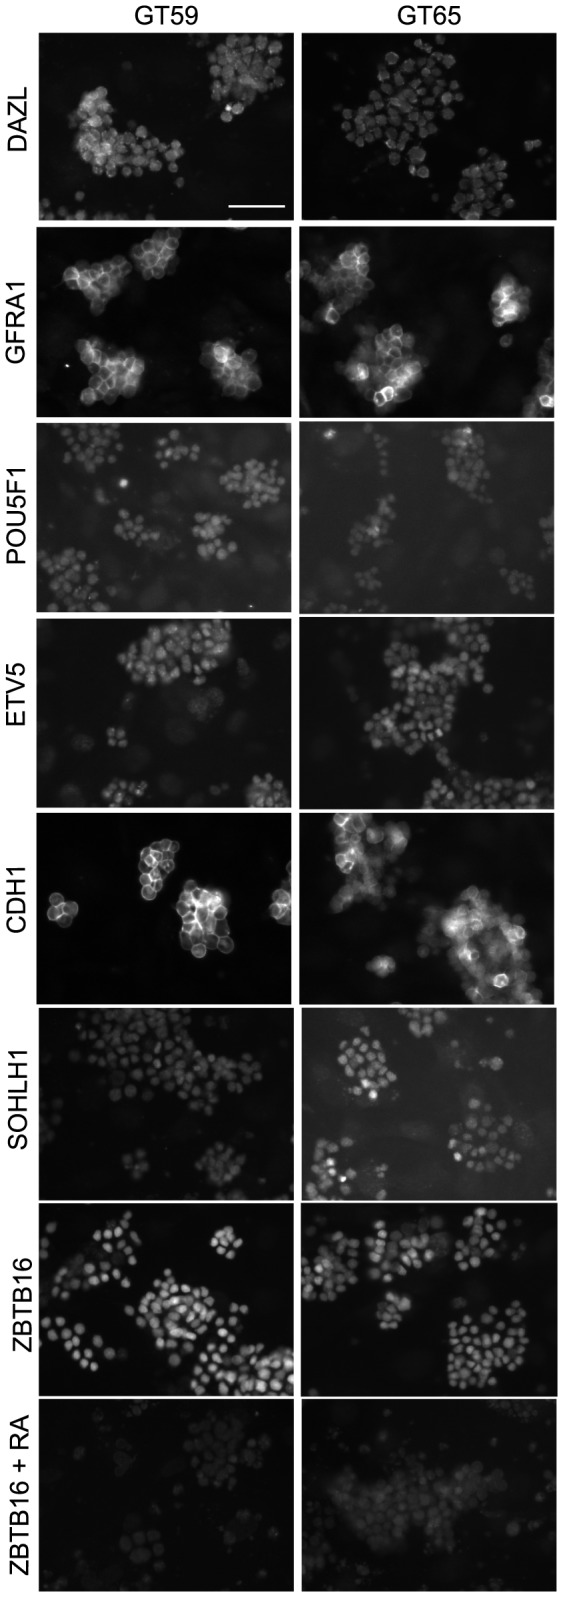
Retention of the spermatogonial phenotype following gene correction.Immunostaining was performed on gene-corrected GT59 (left) and GT65 cells (right): DAZL, a germ cell specific marker; GFRA1, POU5F1, ETV5, CDH1, and SOHLH1, markers of undifferentiated spermatogonia. Additionally, GT59 and GT65 cells were treated with the differentiation factor, retinoic acid (1 µM) or a vehicle control and then immunostained to examine levels of ZBTB16, a marker of undifferentiated spermatogonia. Bar represents 50 microns.